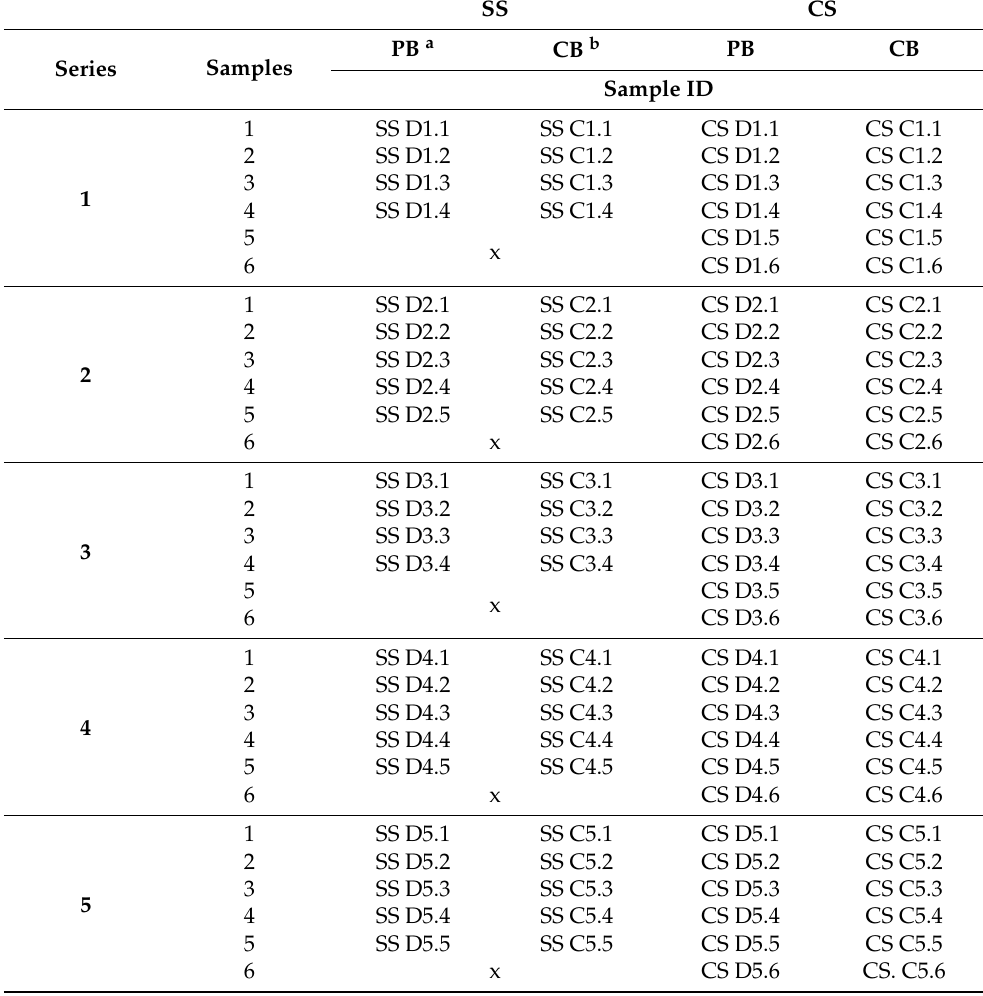
Table 3. Identification numbers (Samples No. 1–No. 9) assigned to SS and CS samples collected from process (PB) and control (CB) bioreactors during the AD process in each experimental series (Series 1–7).